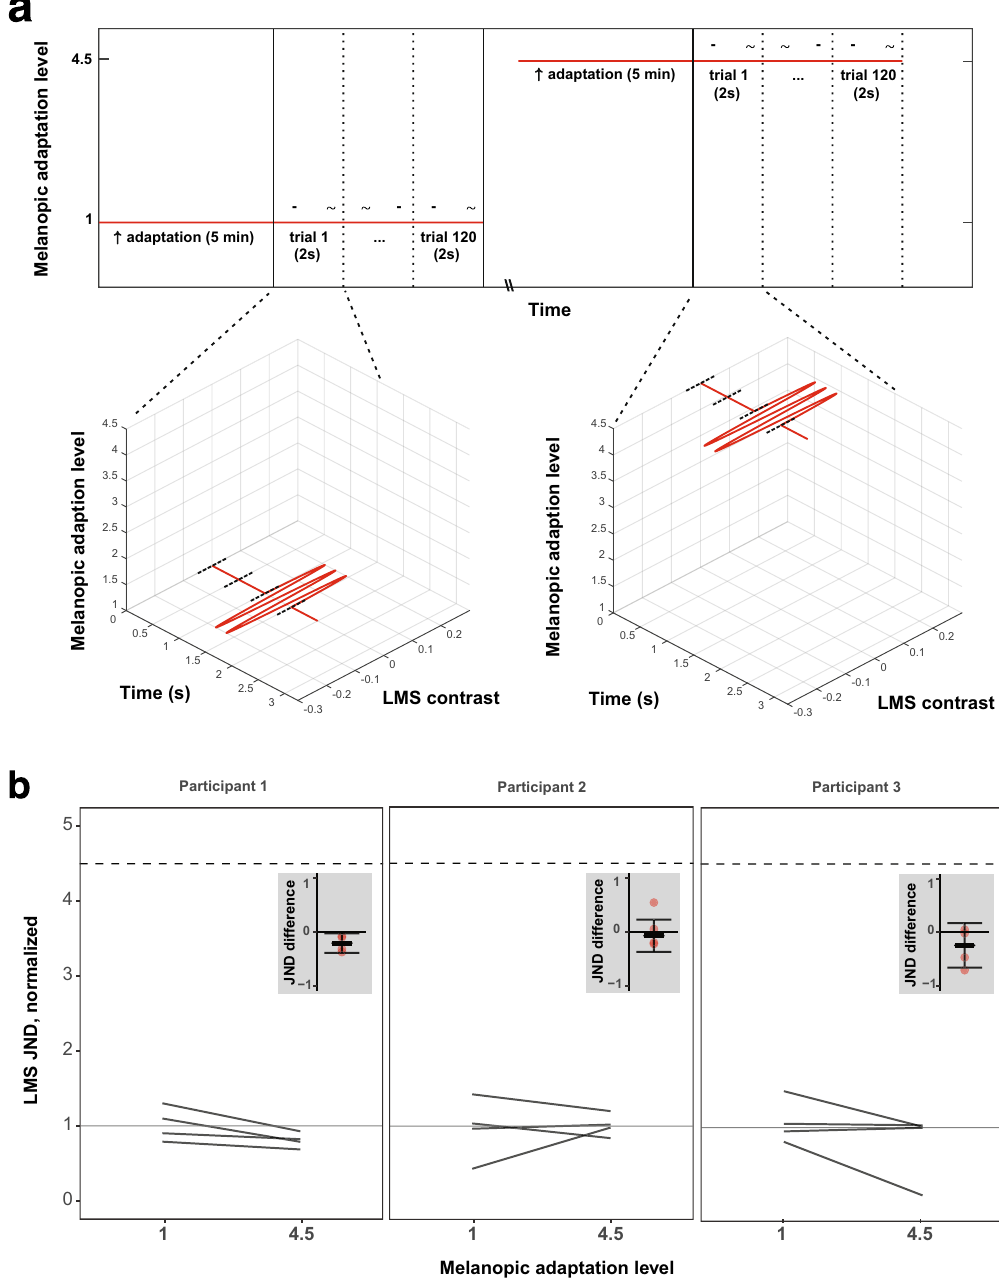
Figure 2. Experiment 1 stimulus and results. ( a ) Each block contained only a single level of melanopic background adapting stimulus (vertical axis gives normalized level: 1 or 4.5) which remained constant through the entirety of that block. Blocks started with an adaptation period of 5 min, during which the participant fixated on the background for that block. Participants then completed 120 trials of a 2IFC task. Individual trials consisted of two 500 ms intervals, each followed by a 500 ms ISI. During either the first or second interval, sinusoidal flicker (5 Hz) directed at the L, M, and S cones was presented around the melanopic background (low-melanopic background case shown on left, high-melanopic background case shown on right); during the other interval no such flicker was presented. After both intervals were presented, participants were asked to indicate which of the two intervals contained the flicker—this response was untimed. Intervals were indicated with an auditory cue. Participants could take a variable-length break in between blocks. Block-order was pseudorandom. ( b ) Experiment 1 results. The plots show cone-directed flicker detection on low- and high-melanopic backgrounds, for the three participants in Experiment 1. Dark gray lines express detection as Just-Noticeable-Difference (JND) from the background in four single sessions. All JNDs for a participant were normalized to that participant’s median JND on the low-melanopic background. If detection of cone- directed flicker was mediated by melanopic stimulation in a Weber’s law fashion, JNDs on the 4.5× higher melanopic background would be 4.5× higher than on the low-melanopic background (dashed horizontal line). Insets: the four red dots show the within-session differences between JNDs at low- and high-melanopic adaptation level. The thicker horizontal line and gray whiskers show the median and confidence interval of the four within-session